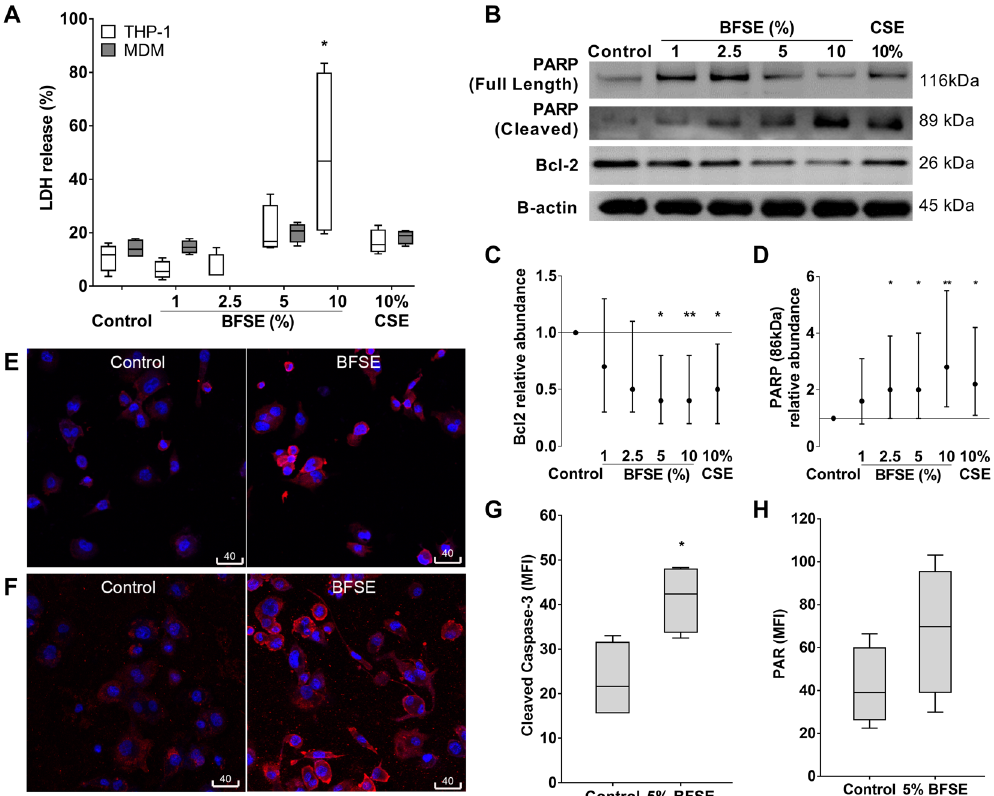
Figure 5. BFSE decreases macrophage viability. THP-1 macrophage, or MDM cells, were exposure to air control or 1%, 2.5%, 5%, 10% BFSE or 10% CSE for 24 h. LDH from THP-1 macrophage or MDM cells was measured in supernatants after 24 h (n = 4) ( A ). THP-1 macrophage expression of Bcl-2 and PARP was assessed by western blot ( B ), band densitometry analysis of Bcl-2 ( C ) and PARP ( D ) was performed, data is a representation of three independent experiments, and was baselined to the air treated control sample, and normalized to β -actin expression. Error bars represent 95% confidence intervals. Representative confocal images of active caspase-3 ( E ) and PAR ( F ), in THP-1 macrophage with quantitative MFI measurement of active caspase-3 ( G ) and PAR ( H ). (n = 4) * p < 0.05, ** p <